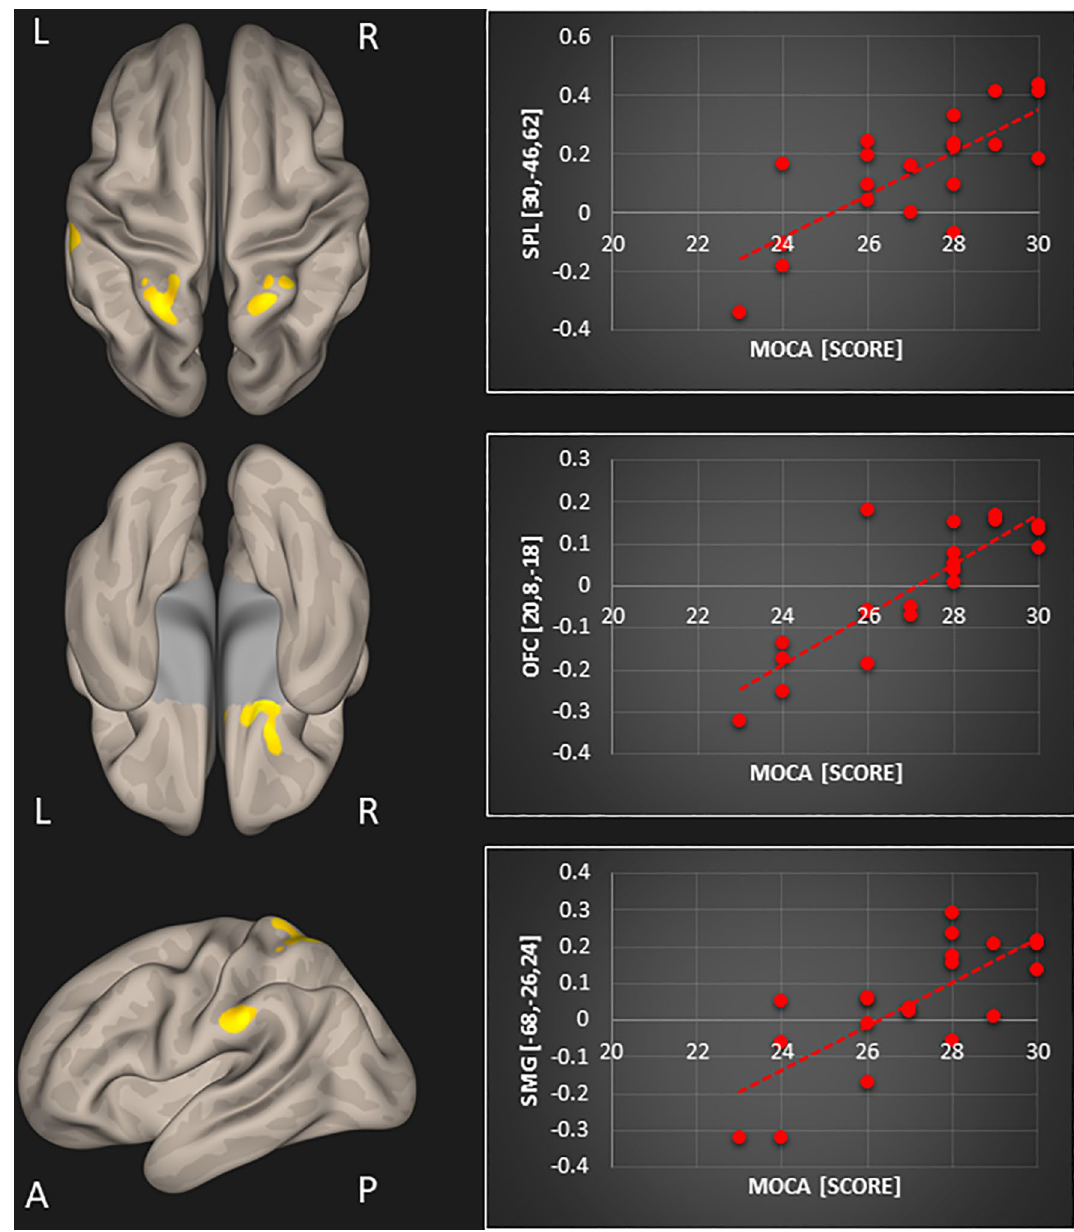
Figure 2. Significant association between MoCA scores and resting-state functional connectivity of the precuneus with the left and right superior parietal lobules (SPL; top row), the right orbitofrontal cortex (OFC; middle row), and the left supramarginal gyrus (SMG; bottom row) in tinnitus patients [p < 0.05; FWE cluster- corrected threshold]. Significant brain areas were displayed on an inflated brain by CONN version 20b 31